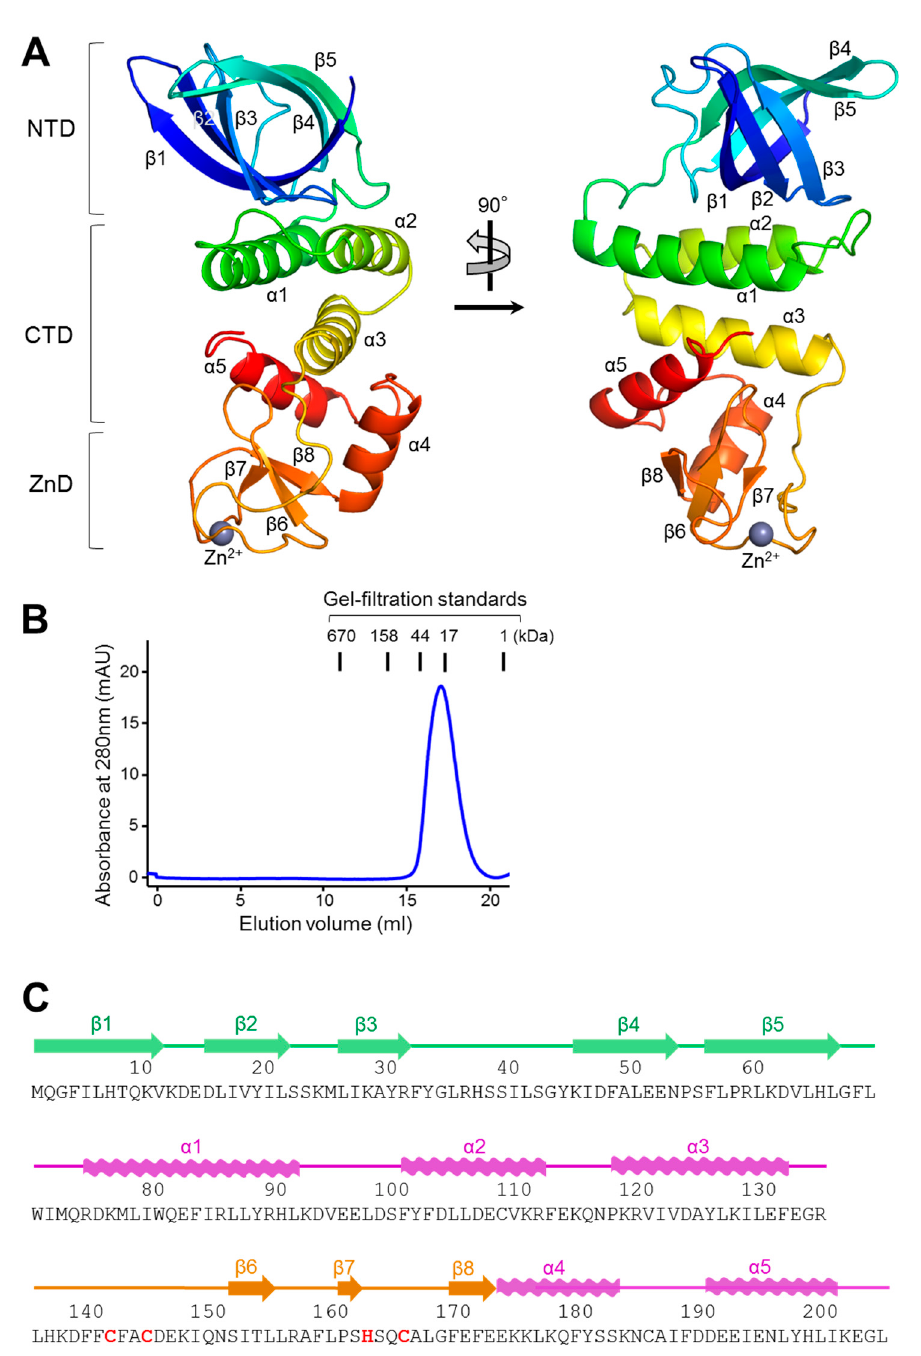
Figure 1. Overall structure and sequence of cjRecO. ( A ) Monomeric structure of cjRecO in rainbow ribbons (N-terminus, blue; C-terminus, red). A Zn 2+ ion is depicted as a light blue sphere in the ZnD. ( B ) cjRecO monomer identified by gel-filtration chromatography. The data are representative of three independent experiments that yielded similar results. ( C ) Amino acid sequence of cjRecO. The Zn 2+ -coordinating residues of cjRecO are colored red. The secondary structures of cjRecO ( α -helices, waves; β -strands, arrows) are shown above the sequence in domain-specific colors (NTD, green; CTD, magenta; ZnD, orange).